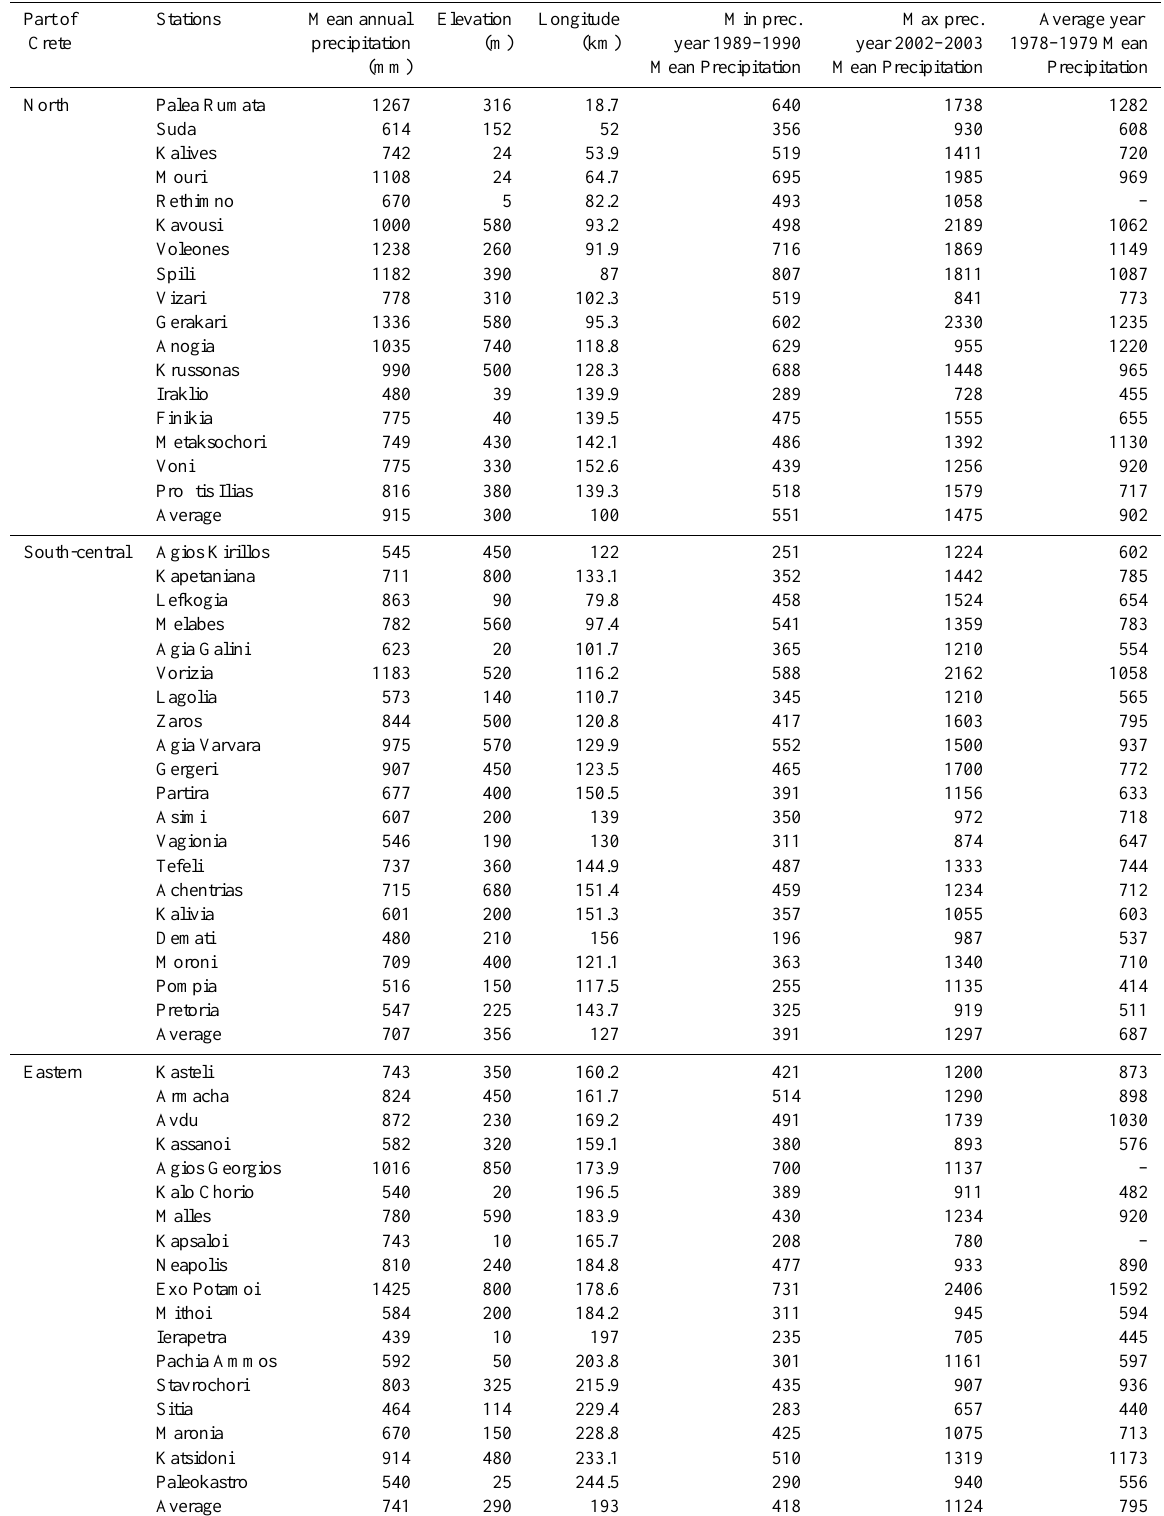
Table 4. Characteristics of the stations used. Part